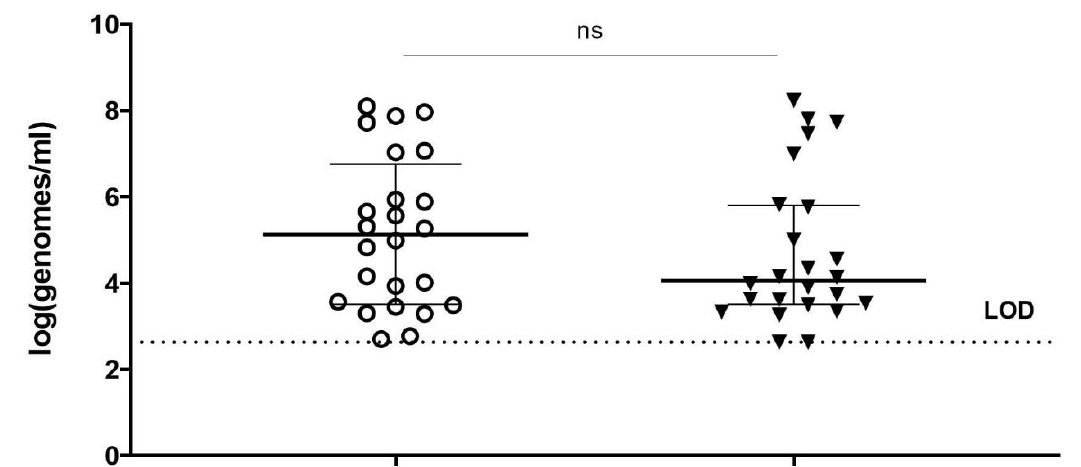
Figure 5. Reduction of cells log(genomes/mL) obtained with PMAxx and genus Lactobacillus genus- specific qPCRs for vaginal samples from women with BV, untreated (transparent circles) and treated with 100 µg/mL PM-477 (black triangles) overnight, shown for Lactobacillus and determined with PMAxx-genus specific qPCR Non significant (ns) as assessed by Wilcoxon test. LOD – limit of detection, ns – non significant.